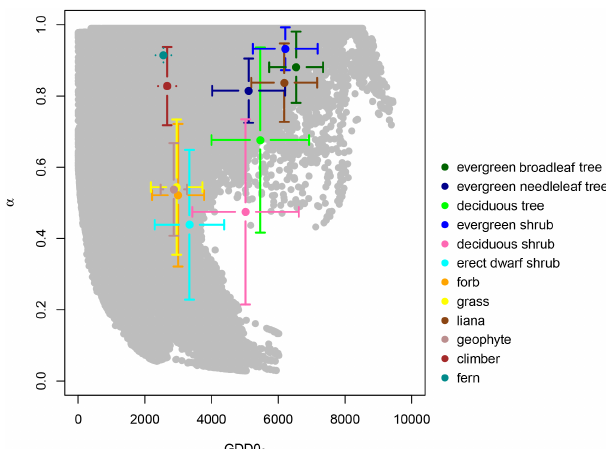
Figure 2. Optima and tolerances of PFTs in climate space of α and GDD 0 (Harrison et al. 2010), based on data from the sampling sites (see Sect. 2.5 for the calculation methods of the optima and tol- erances). The grey dots represent the climates of all grid cells in